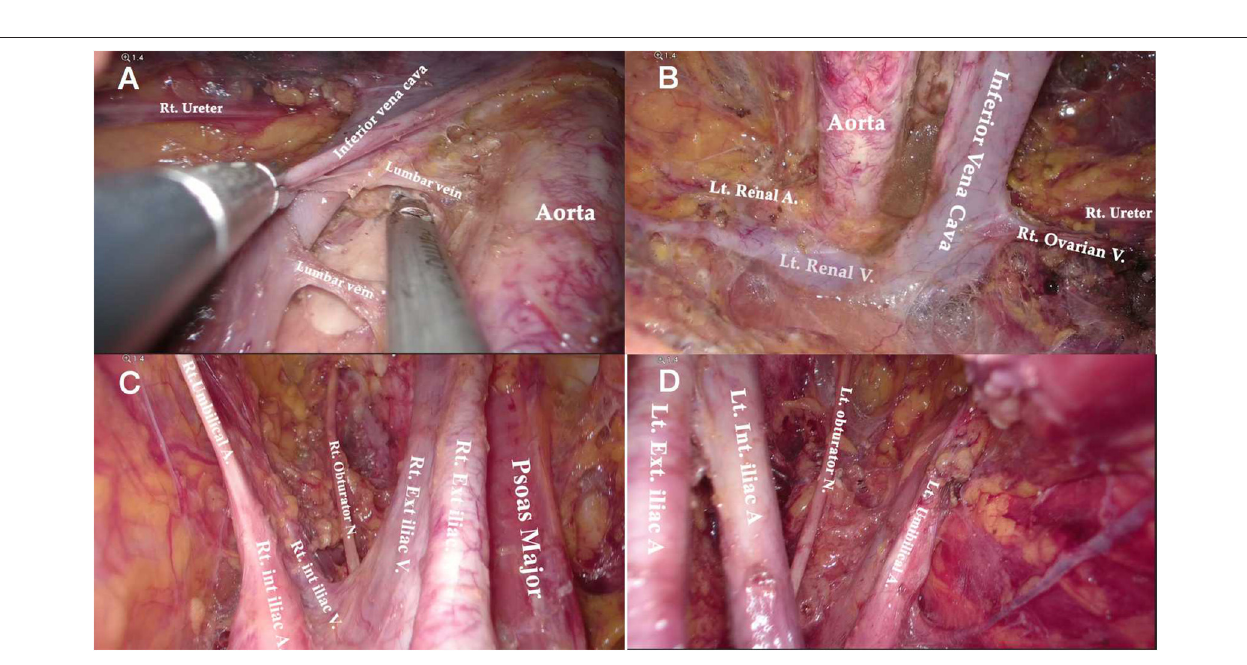
median score of cosmetic effects was 18 (range 15–19) 1 week after surgery and improved to 22.5 (range 21–23) after 30 days ( Figure 8